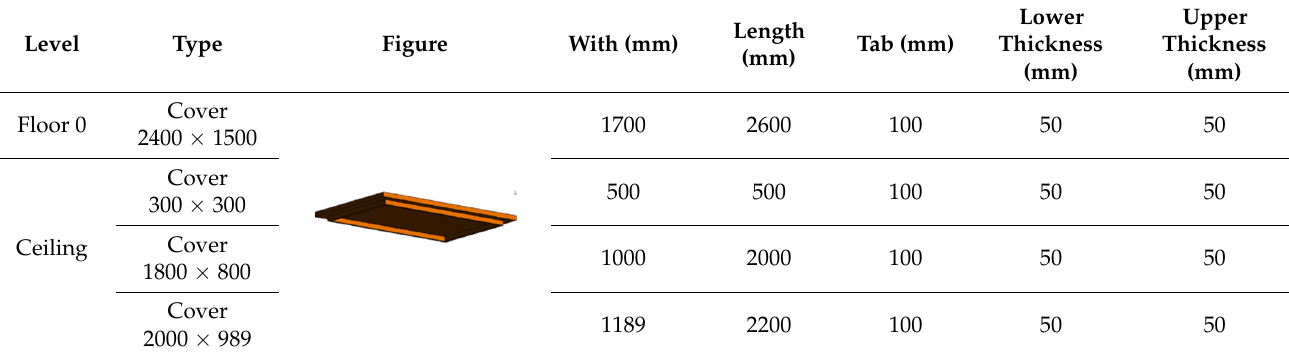
Table 3. Maps of quantities—hole covers (excerpt).